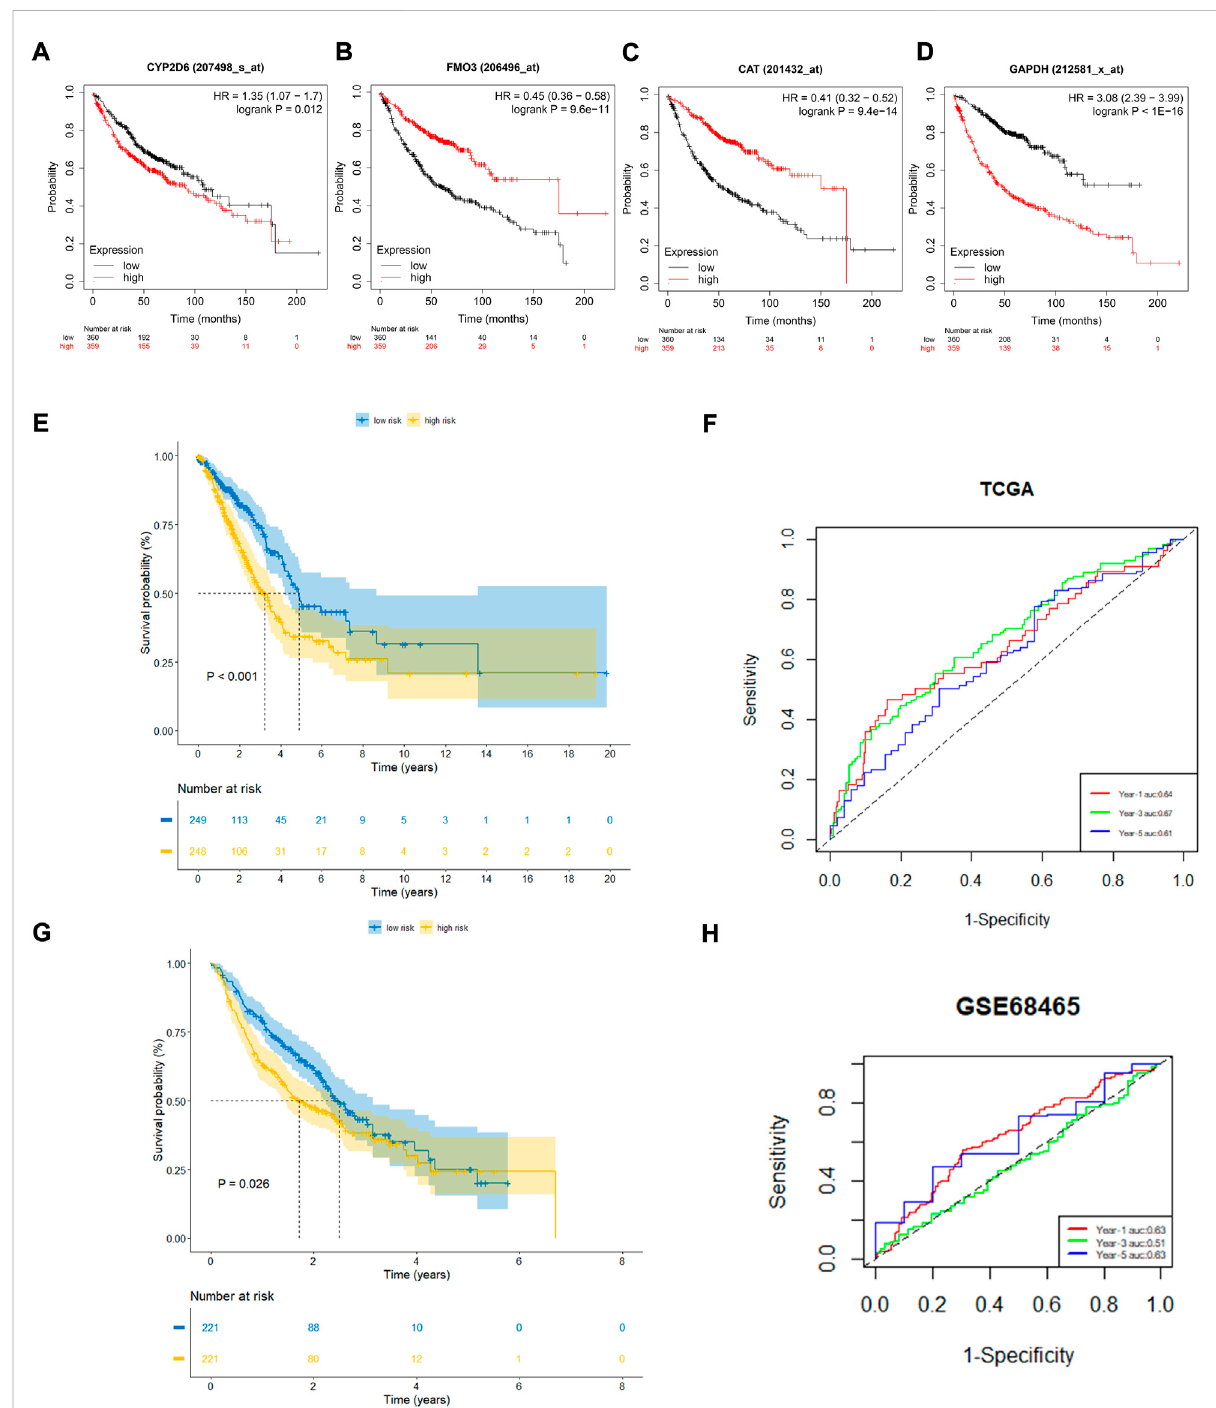
FIGURE 3 The prognostic performance of four genes and risk model. (A – D) Kaplan – Meier curves of four fi ltered genes. (E,F) Kaplan – Meier curves displayed that high-risk group had worse prognosis than low-risk group in TCGA cohort with 1,3,5 years AUCs were 0.64,0.67 and 0.61. (G,H) Kaplan – Meier curves veri fi ed in GEO cohort showed high-risk group had worse prognosis than low-risk group with 1, 3, 5 years AUCs were 0.63, 0.51, and